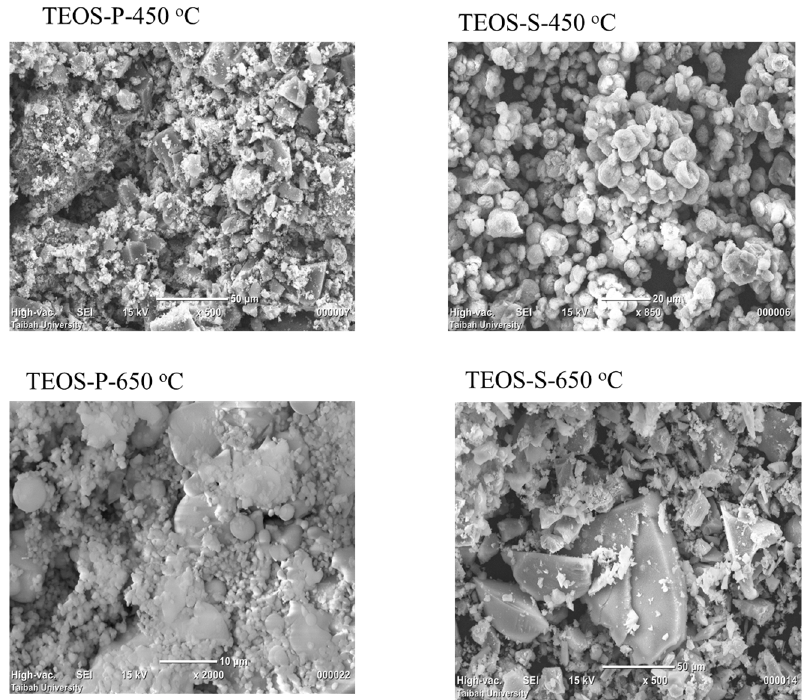
Figure 3. SEM microphotograph of silica prepared from TEOS treated with sulfuric and phosphoric acid calcined at 450 and 650 °C.